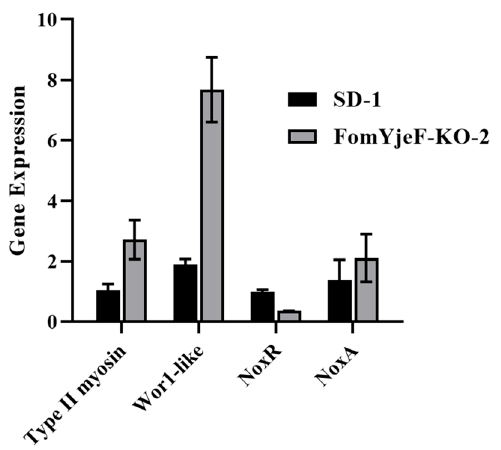
Figure 6. The transcription levels of Type II myosin , Wor1-like , NoxR, and NoxA in the wild-type SD-1 and FomYjeF-KO-2 according to q-PCR using the Type II myosin-F/R, Wor1-like -F/R, NoxR-F/R, and NoxA-F/R primer sets. Error bars represent the SEM of three biological replicates with three technical replicates.